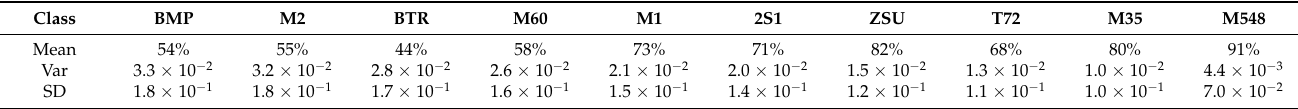
Table 5. EO-only simple net intraclass variance (Var) and standard deviation